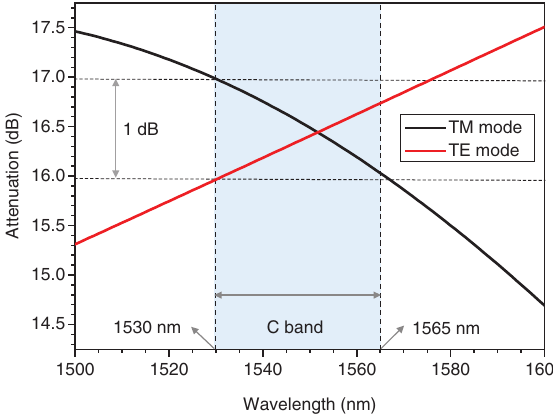
Figure 6: Drive voltage of the graphene-based polarization-insensi- tive optical modulator versus the chemical potential of